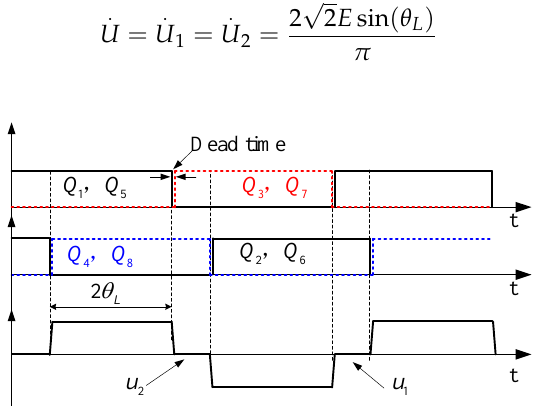
Figure 4. The circuit of proposed WPT system.